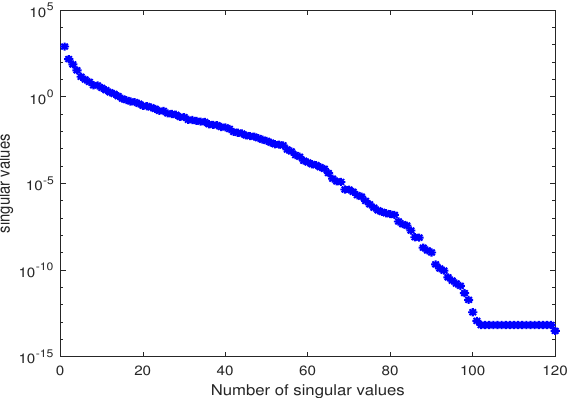
Figure 7. Singular values of the snapshot matrix X for estimating parameters k s 1 , k e 1 , k x 1 and k x 2 .